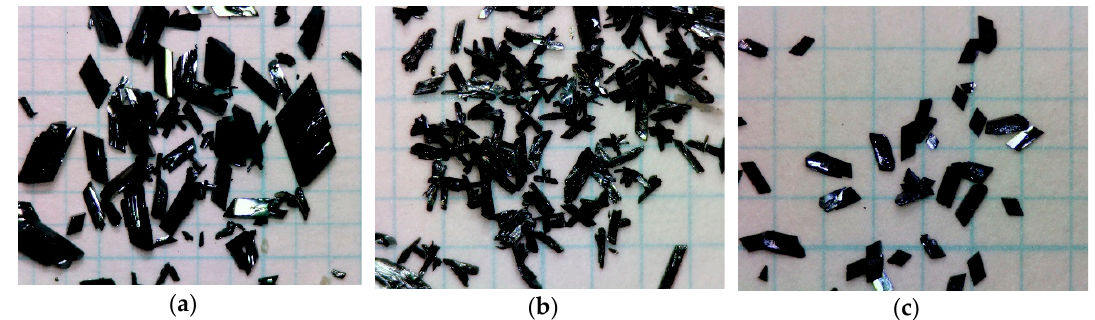
Figure 2. Photographs of crystals for 1 ( a ), 2 ( b ), and 3 ( c ). The grid unit is 1 mm long.